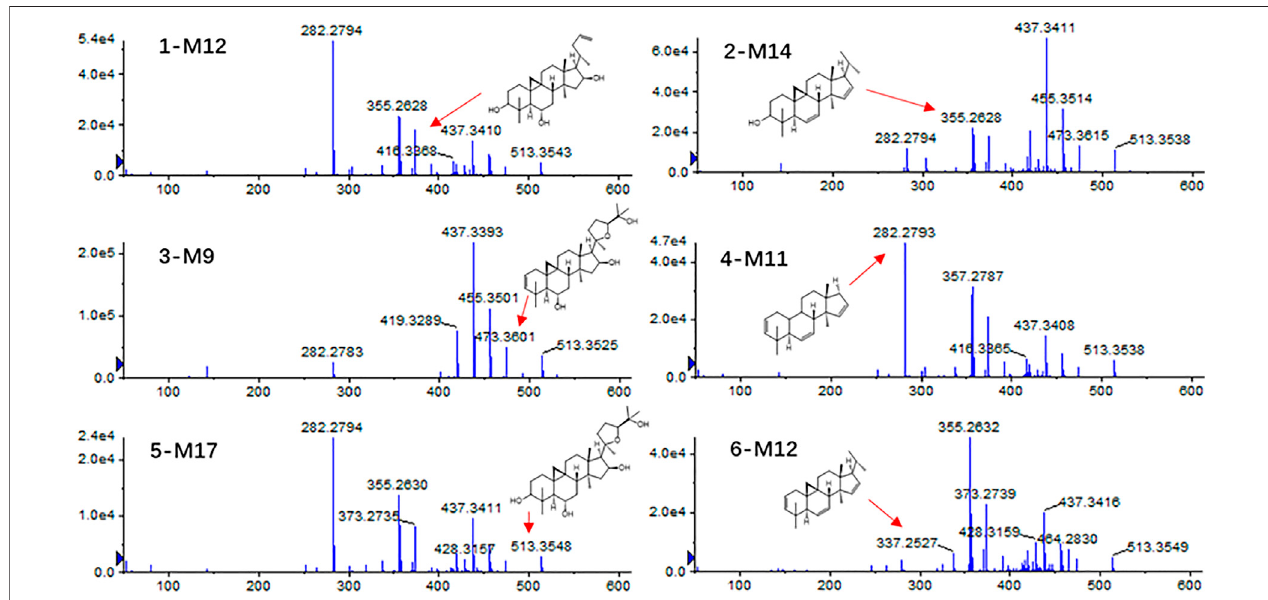
FIGURE 5 | Tandem mass spectra for 1-M12, 2-M14, 3-M9, 4-M11, 5-M17, and 6-M12.